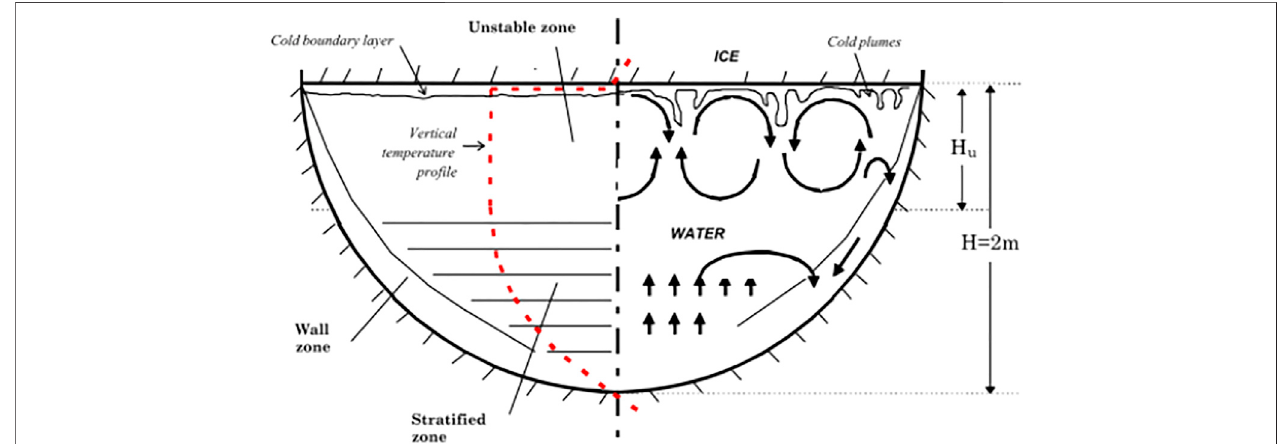
FIGURE 1 | General fl ow observations in BALI experiments (Bernaz et al., 1998).